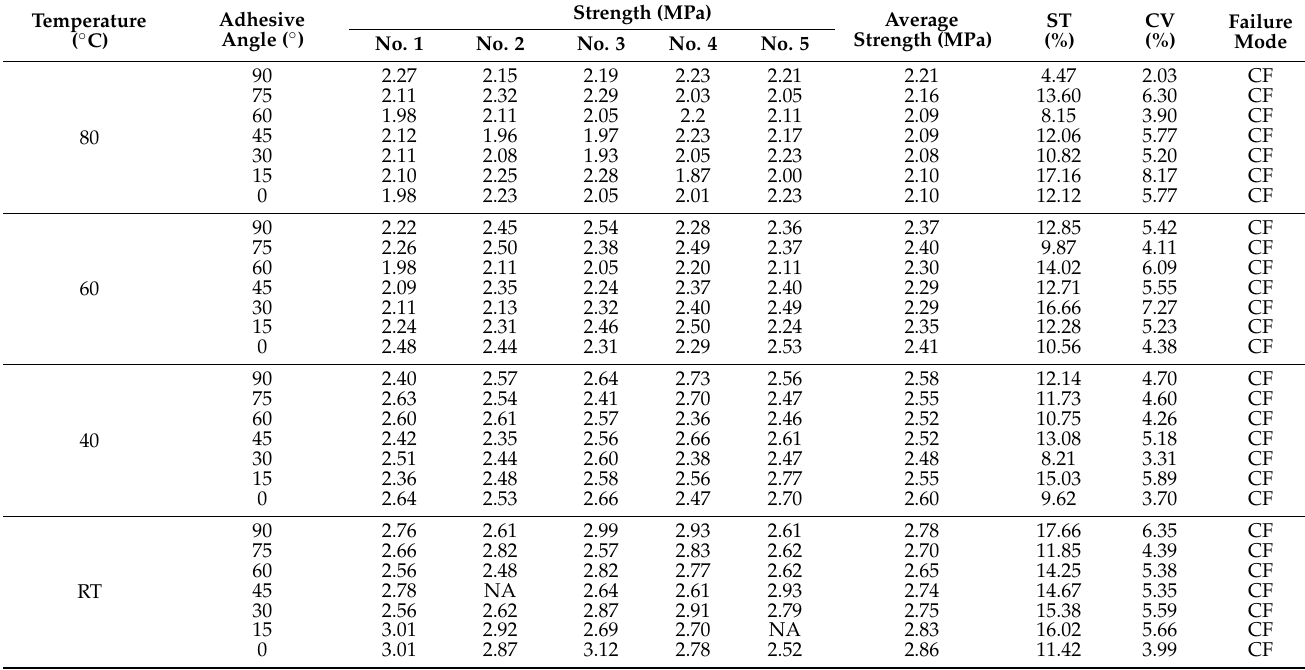
Table 3. Experimental test data of seven groups of adhesive specimens at different angles.